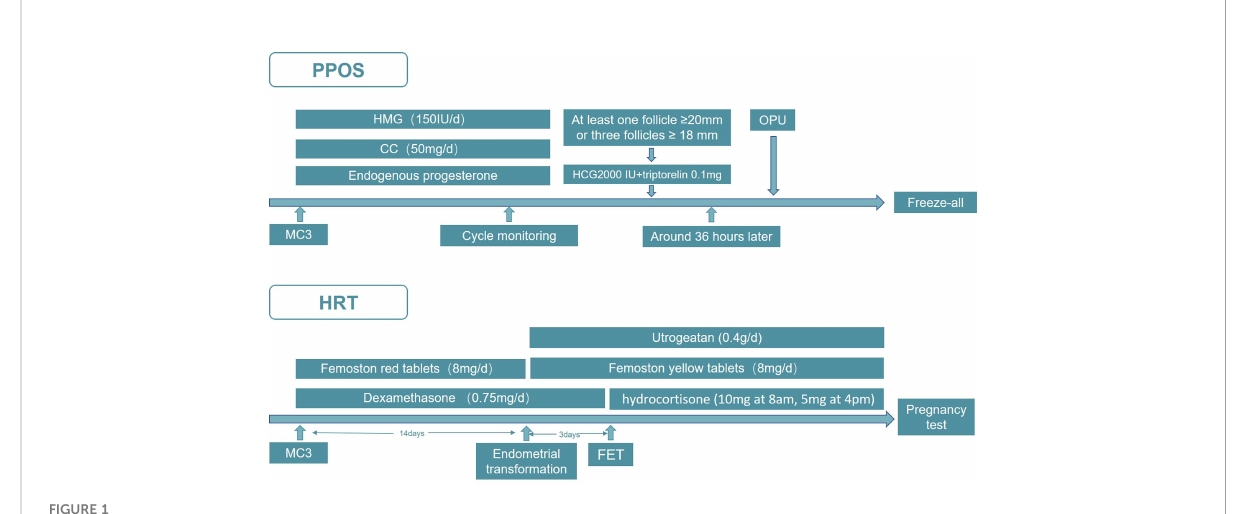
FIGURE 1 The PPOS and HRT protocol used in